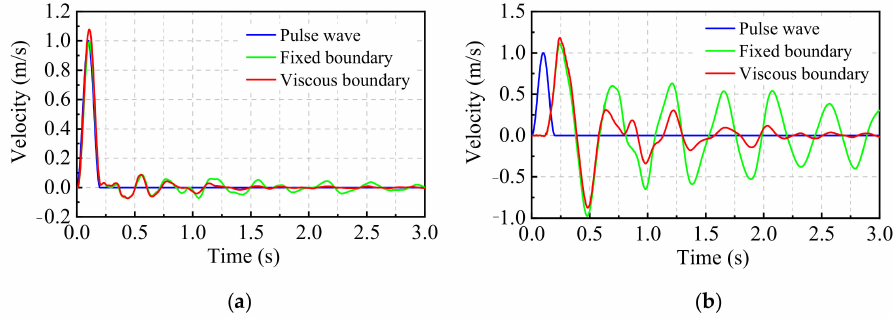
Figure 14. Dynamic responses of the rockfill slope’s PDEM model with different boundary conditions: ( a ) 2-1 monitoring point; ( b ) 2-4 monitoring